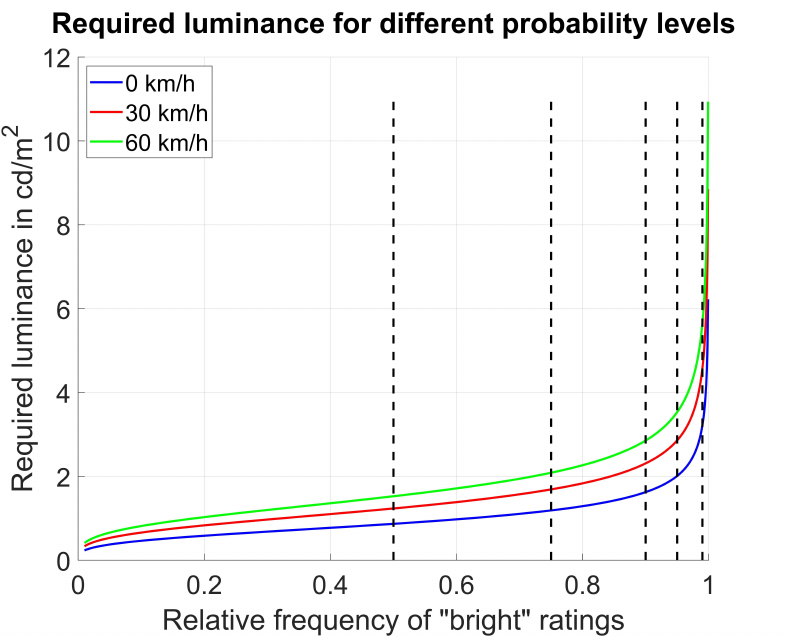
Figure 9. Required luminance for different probability levels of “bright” or better ratings at different speed levels. By using the calculated inverse functions, the minimal roadway luminance, which is required for a “bright” or better evaluation with a certain probability (dashed lines: probability levels 50%, 75%, 90%, 95%, and 99%), can be determined as a function of